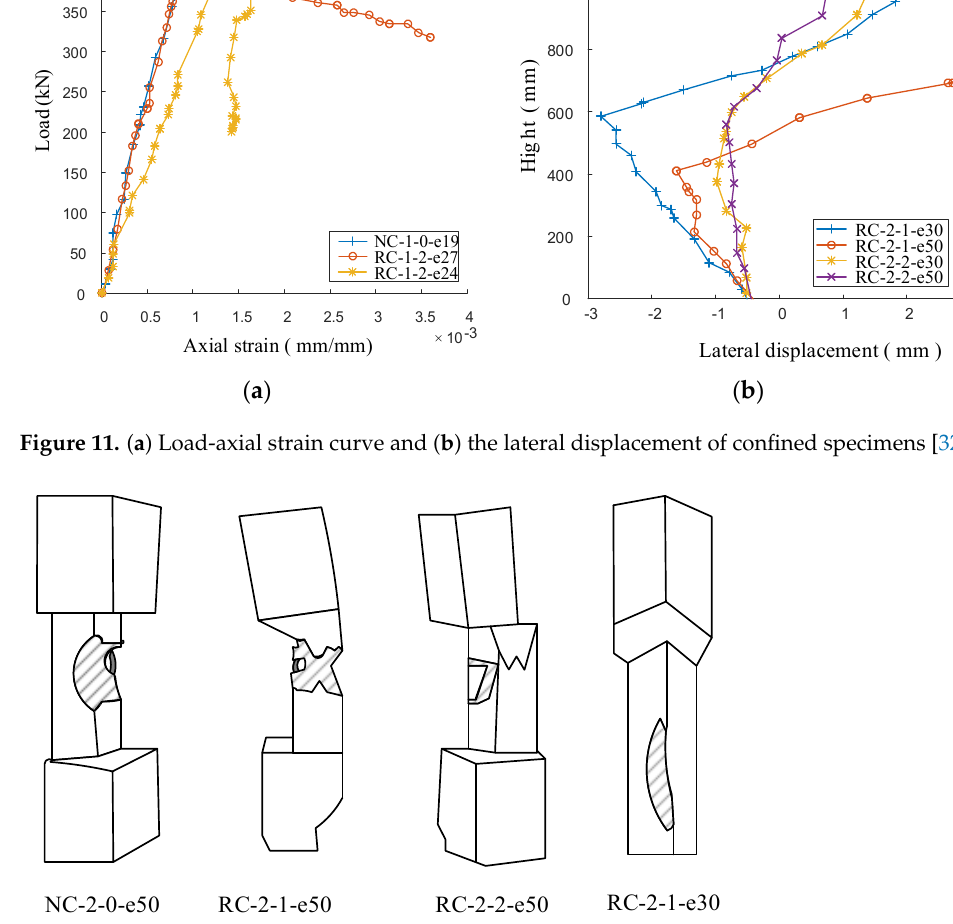
Figure 12. The fracture of strengthened and unstrengthened columns subjected to different scenarios in the form of different load eccentricity and strengthening schemes.